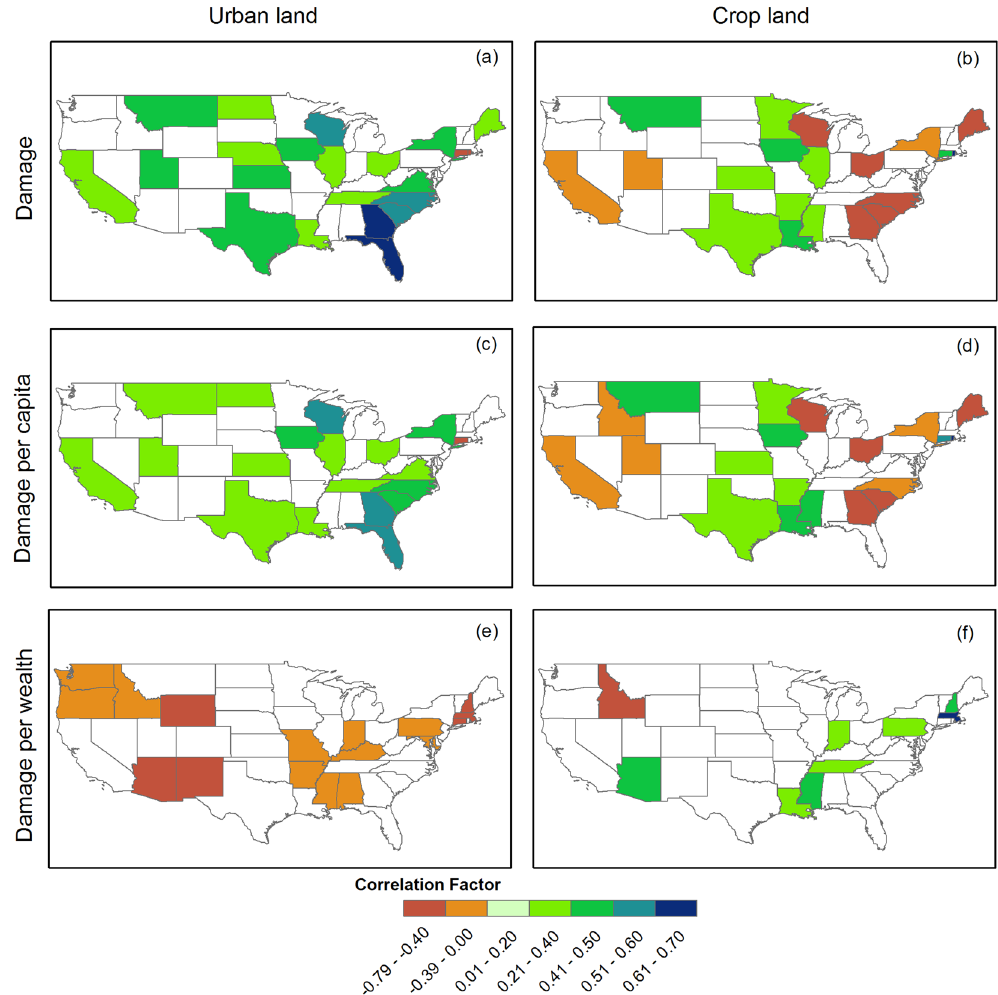
Figure 6. Correlation coefficient between urbanland and cropland areas and log-transformed damage (D), damage per capita (DPC) and damage per unit of wealth (DPW). Only states where statistically significant relations are found at the 90% confidence level are shown. Figure was created using software ArcGIS 10.1 (http://www.esri.com/software/arcgis).